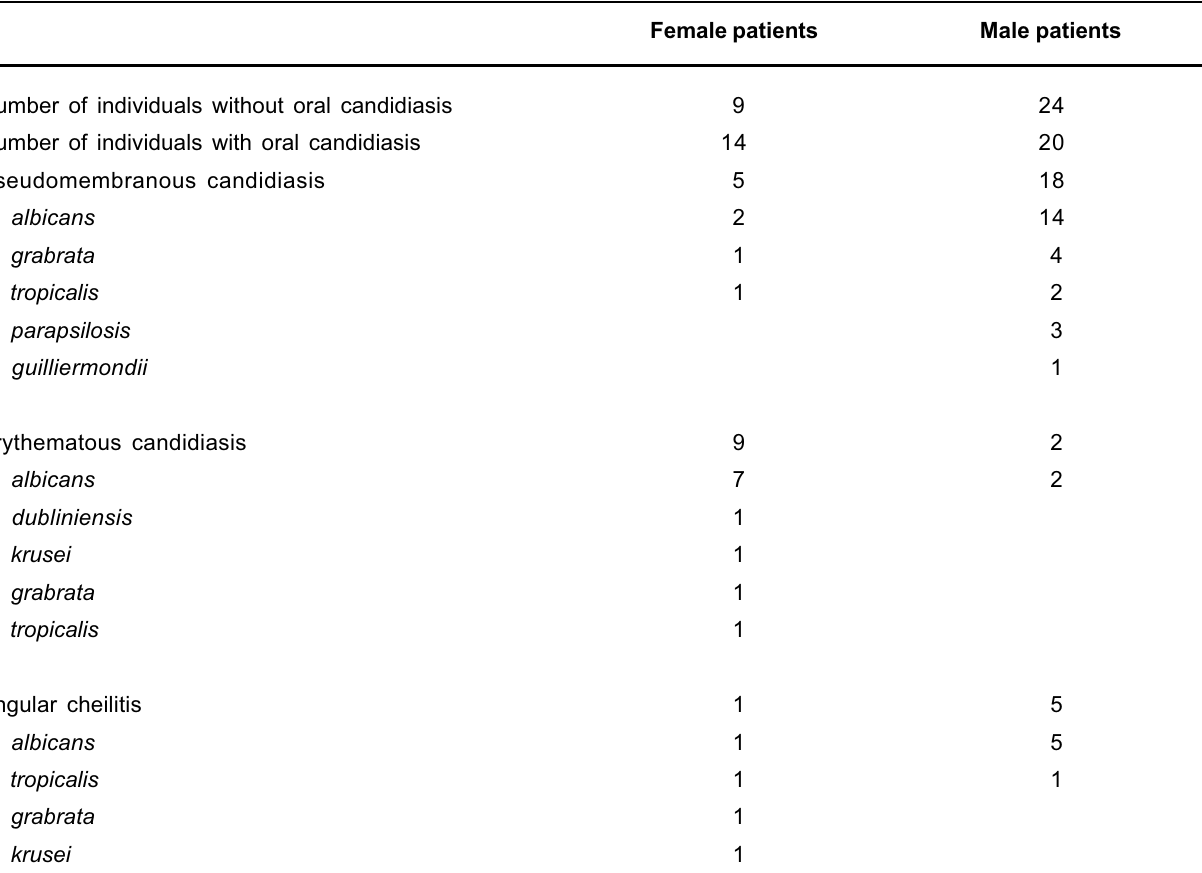
TABLE 1- Oral candidiasis and occurrence of yeasts in lesions of patients with AIDS hospitalized in a public hospital in Belo Horizonte, MG,